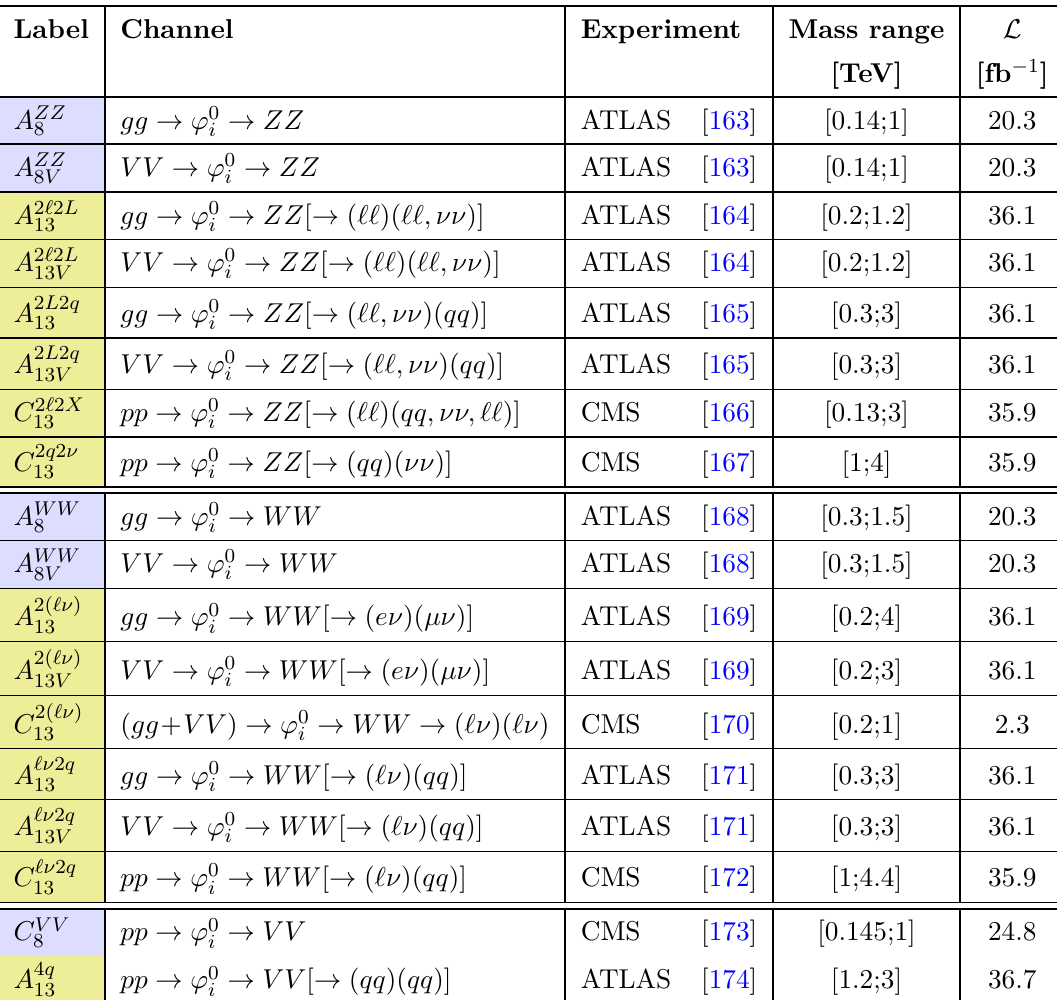
Table 7. Direct searches for neutral heavy scalars, ϕ 0 V = W, Z , ‘ = e, µ